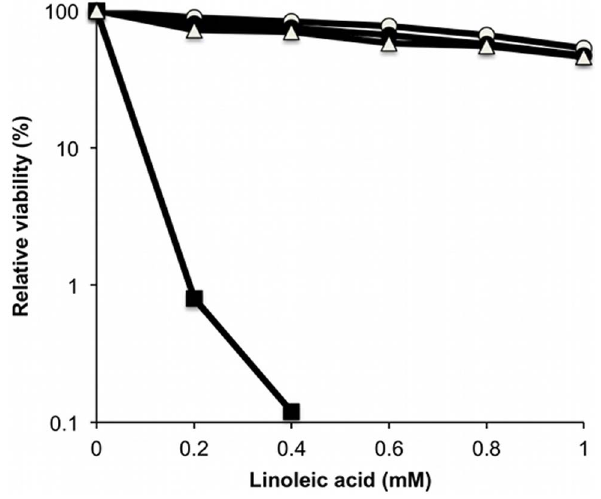
Figure 4. Mtl fermentation capability of S.aureus strains. Mtl fermentation is revealed by acid formation and colour change of the pH indicator to yellow. Liv1023 (SH1000 mtlD :: tet ) and Liv1024 (SH1000 mtlABFD :: tet ) do not ferment Mtl and this capability was restored by complementation with the entire locus in strains Liv1098 (SH1000 mtlD :: tet pMJH71) and Liv1097 (SH1000 mtlABFD :: tet pMJH71). Weak growth of Liv1023 was observed.